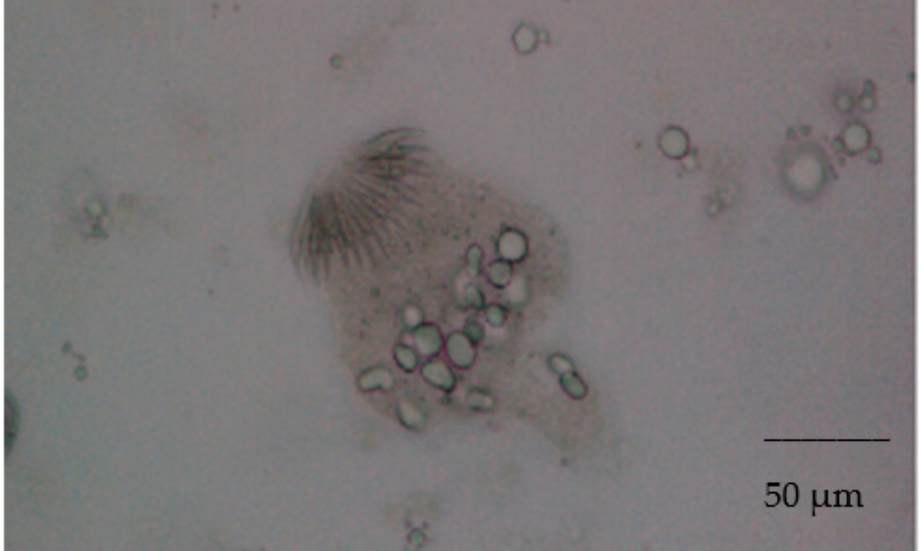
Figure 2. Protoscolex (optical microscope, 40 × ).